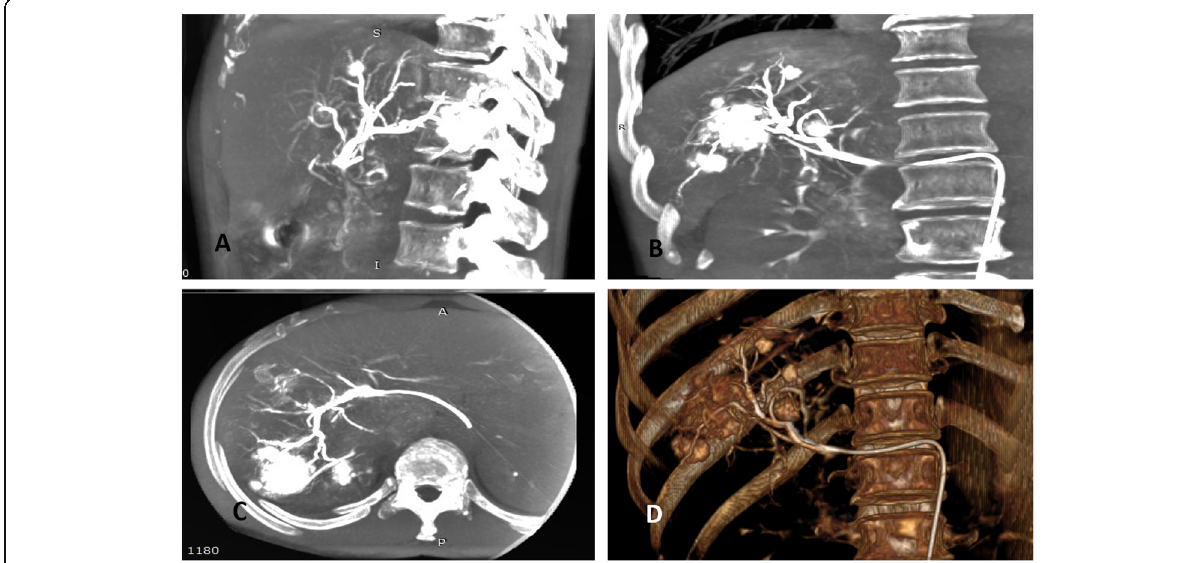
Fig. 2 Multiplanar reconstruction with the use of maximum intensity projection (MIP) of CBCT-HA in a case of multi-focal HCC ( a sagittal, b coronal, and c axial) revealing the feeding arteries of the different lesions even the smallest ones. d 3D virtual reconstruction revealing the feeding arteries with good confidence even in the presence of